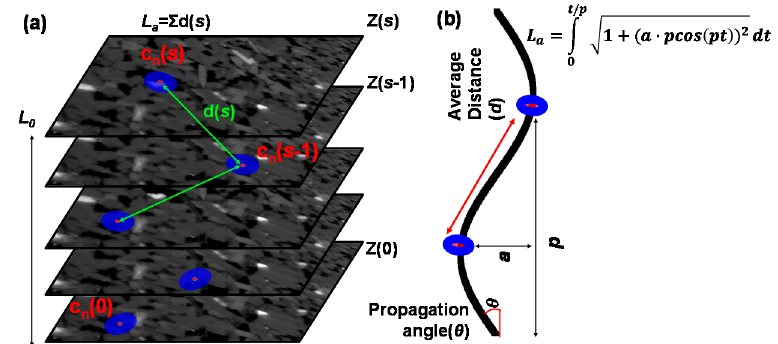
Figure 5. Method for construction of a tortuous flow channel model. ( a ) Estimation of centroid tortuosity in Avizo program. ( b ) Incorporation of a sine curve with information of connected pores along the z -axis into a tortuous flow channel.